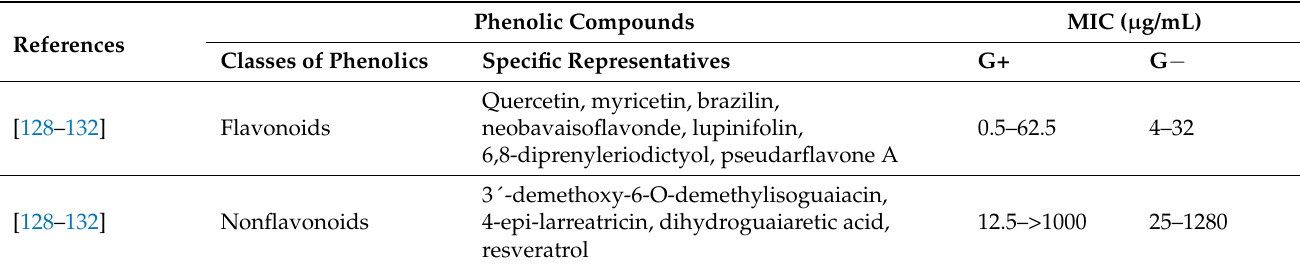
Table 4. The minimum inhibitory concentrations of selected phenolic compounds against gram-positive and gram- negative